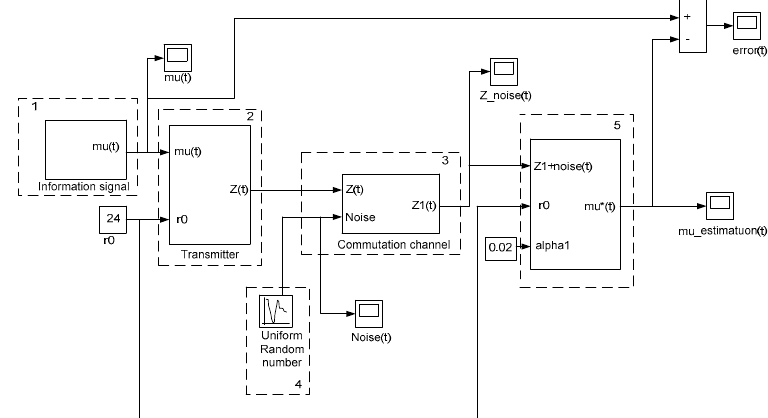
Figure 12. MATLAB/Simulink overall secure communication system block diagram with a two-channel synergetic observer. Here: block 1 is the useful signals source; block 2 is the transmitter with a chaotic generator; block 4 simulates errors in the communication channel; block 3 is the communication channel; and block 5 is the receiver (two-channel observer).